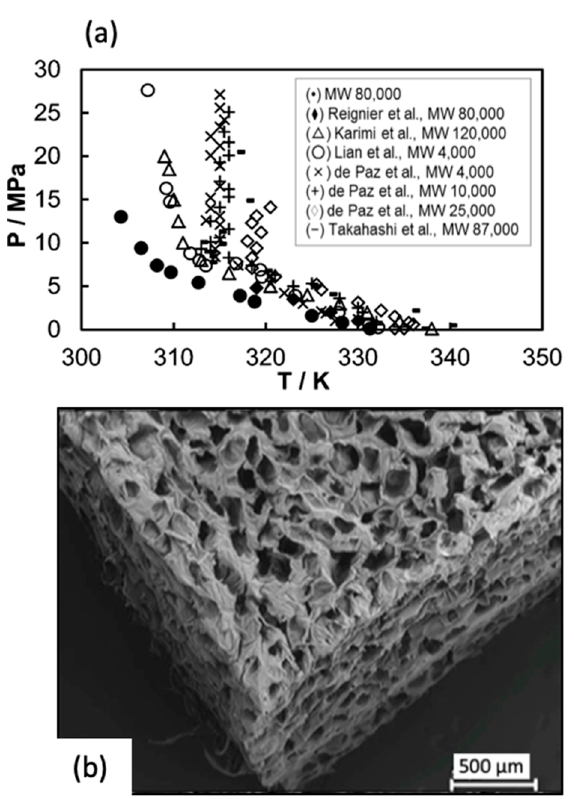
Figure 8. ( a ) Solid–liquid transition for PCL of different molecular weights (MW) in the presence of CO 2 under certain pressure (y axis) and temperature (x axis) [95] . ( b ) Micrograph of PCL scaffold